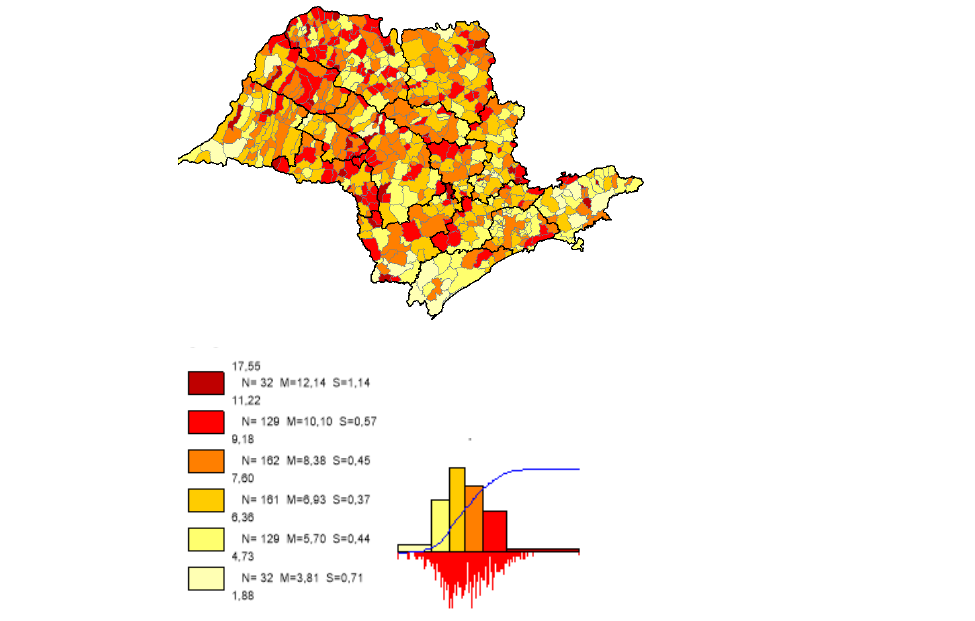
Figure 6. Distribution map of the potential reduction in IM rates in the municipalities of the state of SP, fixed effects. Note: Choropleth maps, consisting of six divisions, using the following limits— minimum value; 5th percentile; 25th, 50th and 75th percentiles; 95th percentile and maximum value. For each interval, the number (N) of municipalities, their mean (M) and standard deviation (S) are described. The histograms contain bars proportional to the number of localities in each division ( Philcarto images).